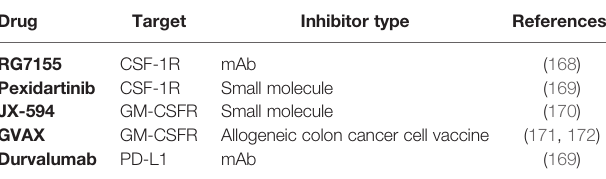
TABLE 3 | Current clinical trial drugs targeting TAMs in mCRC